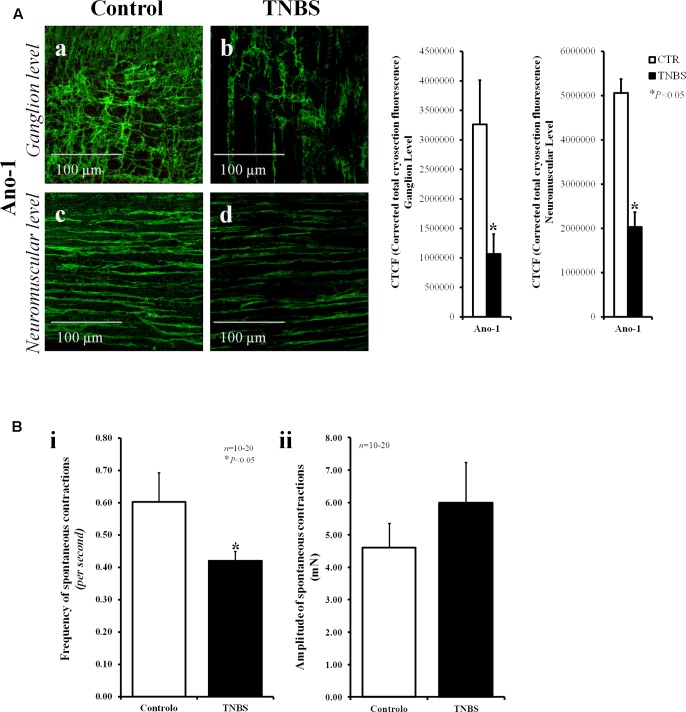
The partial loss of anoctamine-1 (Ano-1)-positive ICCs in the myenteric plexus of TNBS-treated rats correlates with the reduction in the frequency of spontaneous contractions of the rat ileum. (A) Confocal micrographs of whole-mount preparations of the ileum of control and TNBS-injected rats taken at the myenteric ganglion level (a,b) and at the longitudinal smooth muscle layer (c,d). Shown is the immunoreactivity against Ano-1, a calcium-activated chloride channel involved in the pacemaker activity of ICCs. Images are representative of at least five different animals per group. Scale bars = 100 μm. Bar charts at the right hand-side panel represents mean ± SEM of corrected total cryosection fluorescence (CTCF) of Ano-1 staining at the ganglion level and at the neuromuscular region. (B) Histograms representing the frequency (i) and the amplitude (ii) of spontaneous myographic contractions of the ileum from control rats and TNBS-treated animals. The data are mean ± SEM of an n number of animals. ∗P < 0.05 (unpaired Student’s t-test with Welch correction) represents significant differences from control animals.